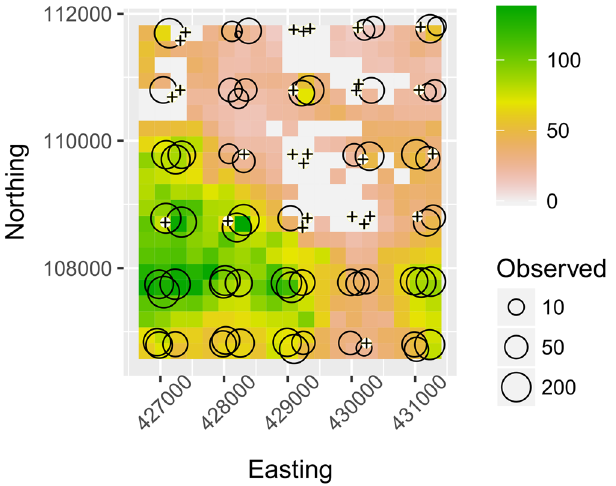
Figure 4. Interpolation of Vouacapoua americana fruit-fall. Interpolated biomass across the Amapá National Forest survey grid at 250 m pixel resolution. White spheres with crosses show locations of plots without fallen fruits. Predicted values (color scale, kg ha −1 month −1 ) are the weighted mean from six methods (Inverse Distance Weight, Universal Kriging, Generalized Additive Model, Generalized Linear Model, Random Forest and Support Vector Machine. For model details see Supplementary